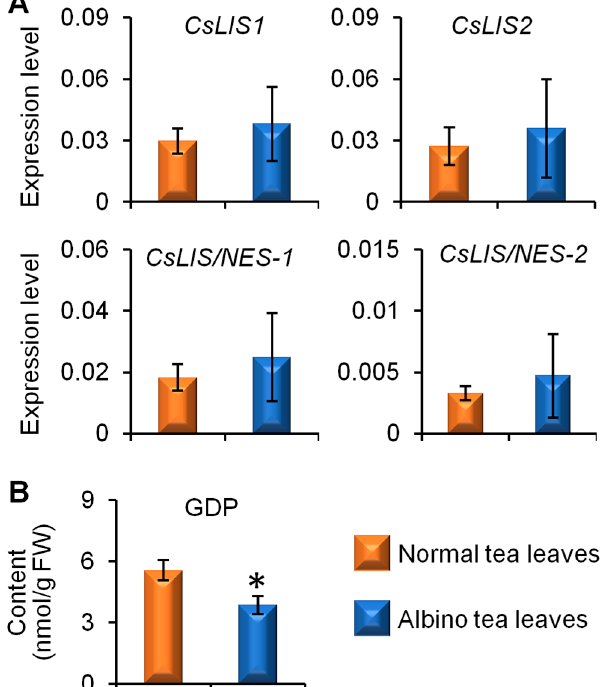
Figure 5. Differential expression levels of genes involved in linalool synthesis ( A ) and accumulation of geranyl diphosphate (GDP) ( B ) in normal green and albino-induced yellow tea ( Camellia sinensis ) leaves (cv. Yinghong No. 9) collected in April. ( A ) LIS , linalool synthase ; LIS/NES , linalool synthase/(E)-nerolidol synthase . ( B ) FW, fresh weight. All data are expressed as mean ± S.D. ( n = 3). Significant differences between normal and albino tea leaves are indicated (* p ≤ 0.05).